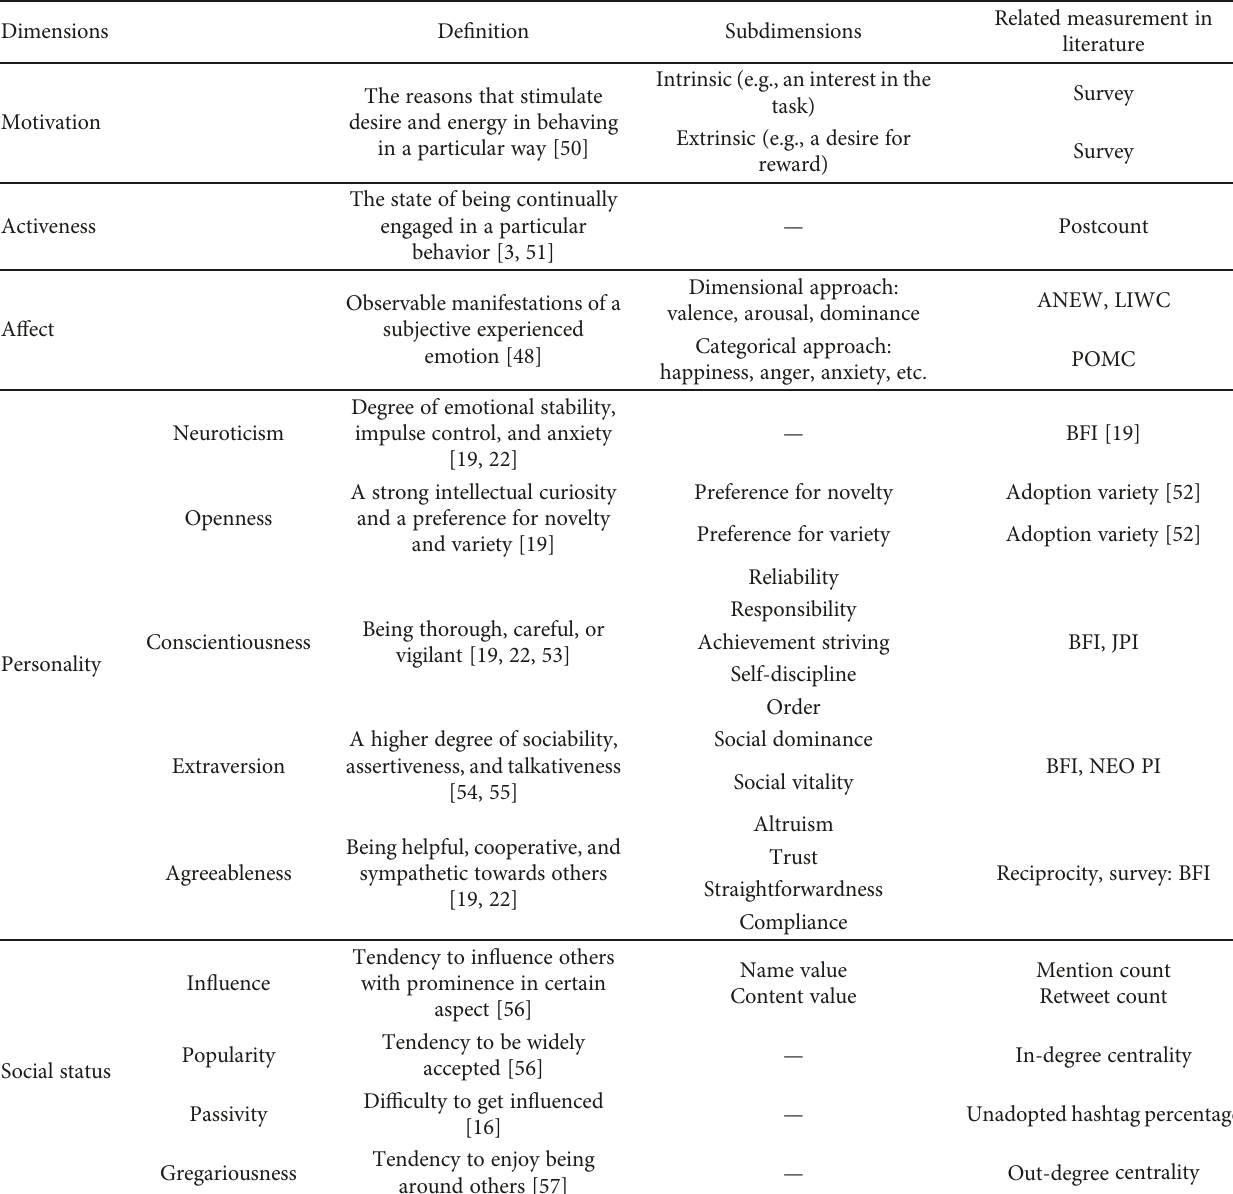
Table 3: Surveyed candidates for user-oriented behavior interior